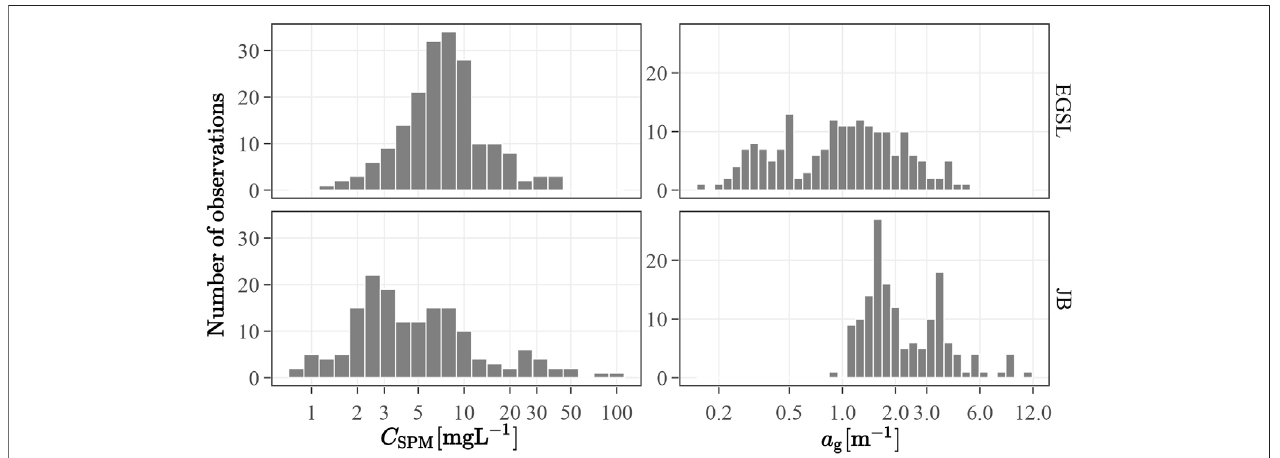
FIGURE 2 | Histograms showing the distribution of C SPM and a g (400) in the EGSL and JB.